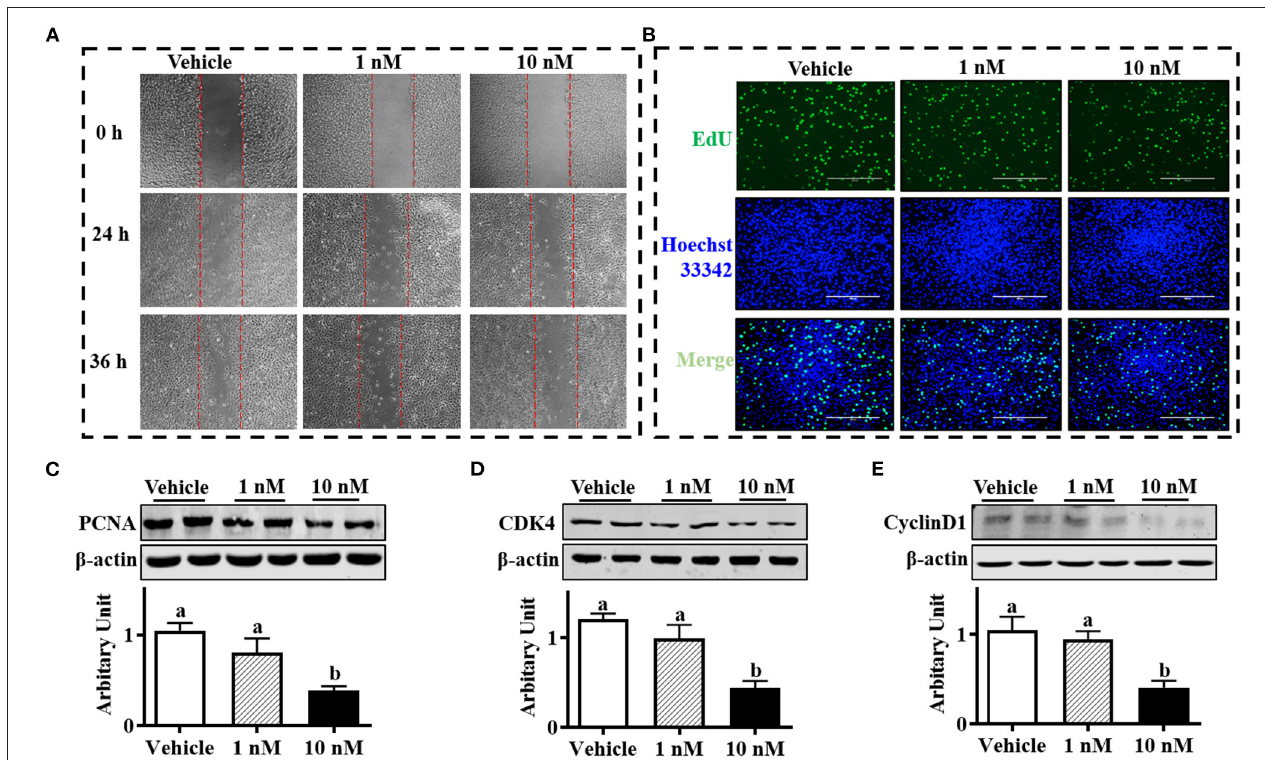
FIGURE 1 | Melatonin inhibited sheep brown precursor cell proliferation. Isolated cells were treated with melatonin (1 and 10nM) or vehicle for 24h. (A) Wound healing scratch assay. (B) EDU staining. (C–E) PCNA, cyclin D1, and CDK4 protein abundances analyzed by Western blotting ( n = 6, mean ± SEM; different letters mean significant